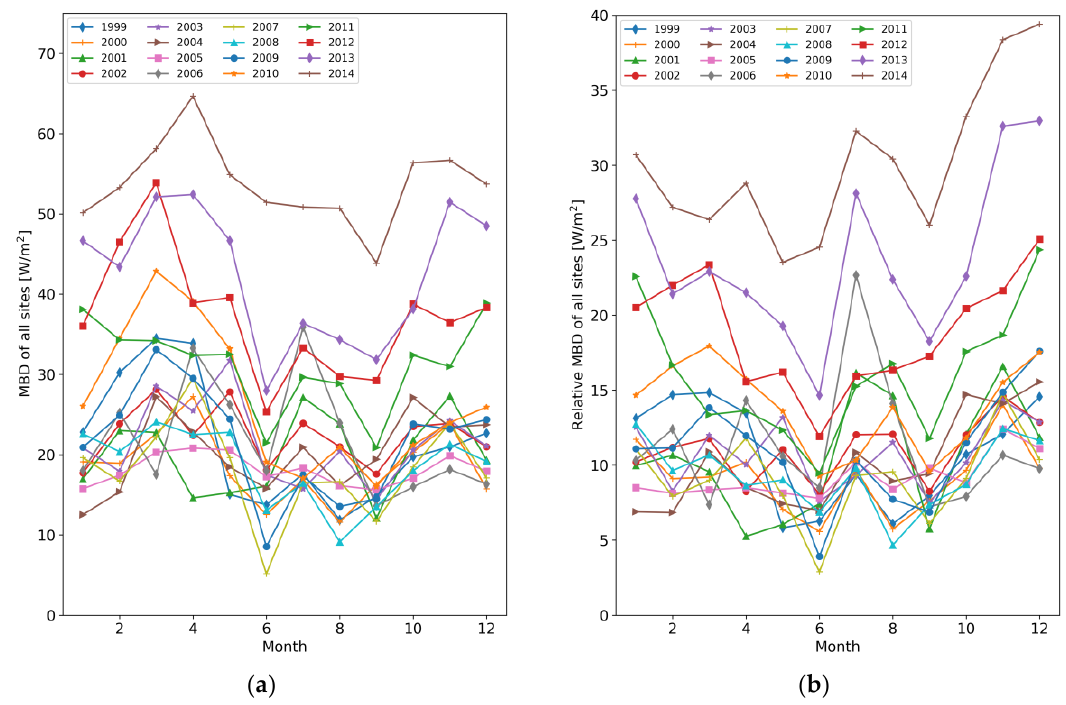
Figure 3. ( a ) Monthly mean MBD of SARAH-E vs. all validation sites resolved for 1999–2014; and ( b ) relative monthly mean MBD of SARAH-E vs. all validation sites resolved for 1999–2014.